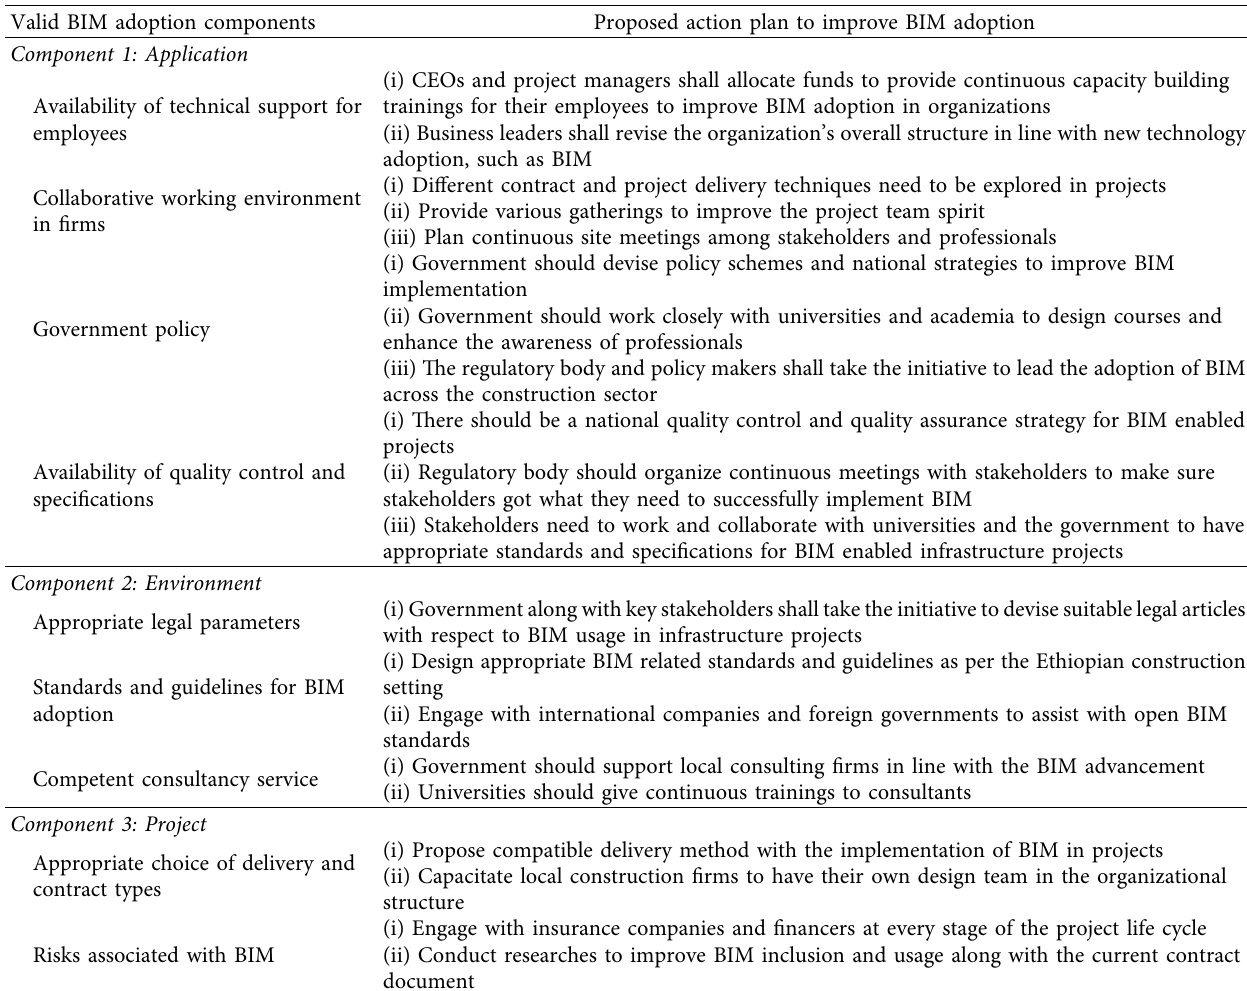
Table 9: Action plan to improve BIM adoption across the Ethiopian infrastructure construction industry. Valid BIM adoption components Proposed action plan to improve BIM